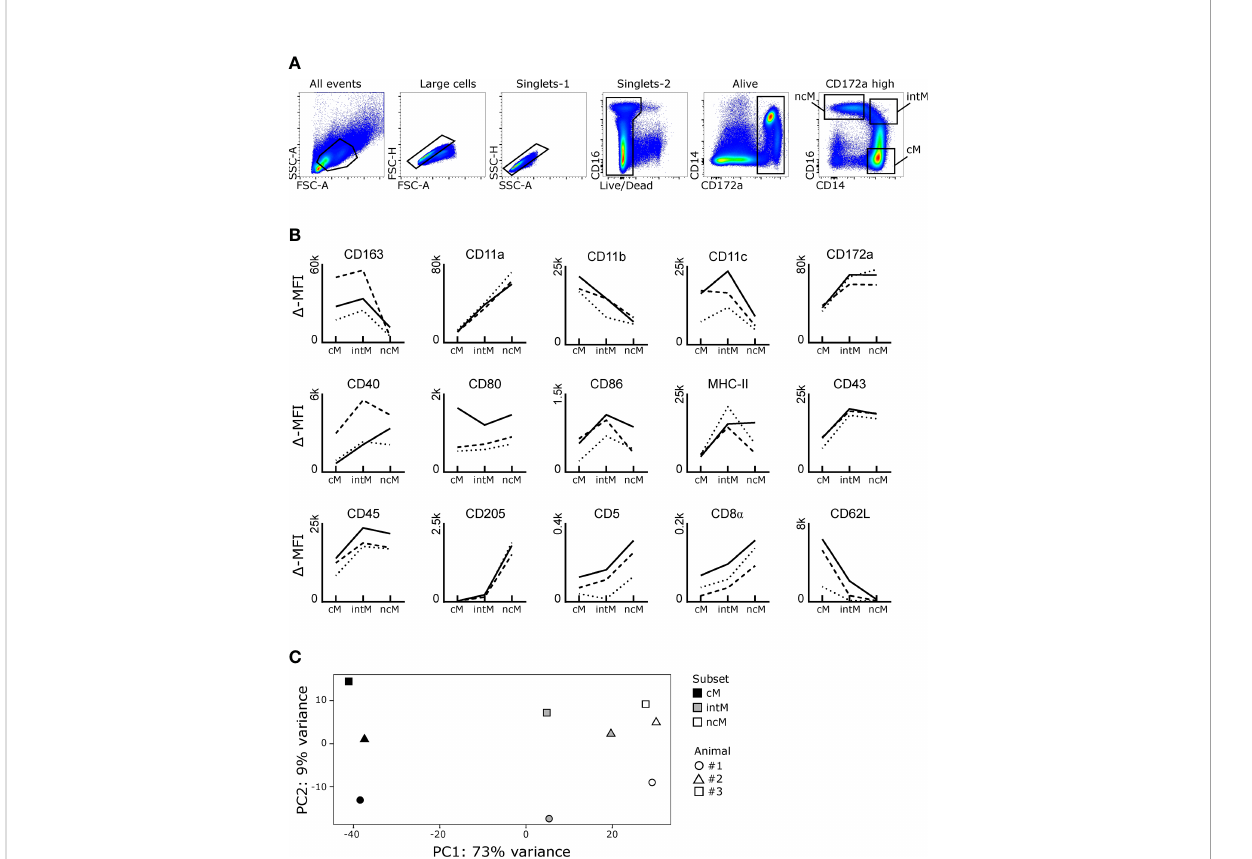
FIGURE 1 Phenotype and transcriptional clustering of bovine monocyte subsets. (A, B) Flow cytometric analysis. Freshly isolated PBMC were stained for fl ow cytometry. Monocyte subsets were gated based on expression of CD14 and CD16 within CD172a high cells after gating on large cells (FSC high ), single cells (within diagonal in FSC-A vs. FSC-H and SSC-A vs. SSC-H), and living cells (Near-IR low ). Classical monocytes (cM) were gated as CD14 high CD16 - , intermediate monocytes (intM) as CD14 high CD16 high , and nonclassical monocytes (ncM) as CD14 -/dim CD16 high . (B) Graphs show the delta median fl uorescence intensity (MFI) of surface expression for selected molecules. Delta MFI was calculated as the difference in MFI between stained samples and FMO controls. Lines illustrate the delta MFI across monocyte subsets. Stainings were performed on seven different animals, resulting in 3 animals analyzed per marker. Within single graphs, data of three different animals is illustrated by solid, dashed, and dotted lines. (C) First two axes of a principal component analysis (PCA) including the 1000 most variable genes. Illumina sequencing was performed on RNA isolated from sorted monocyte subsets of three animals. Each dot represents one sample, with the color coding for different cell subsets and the shape coding for the three different